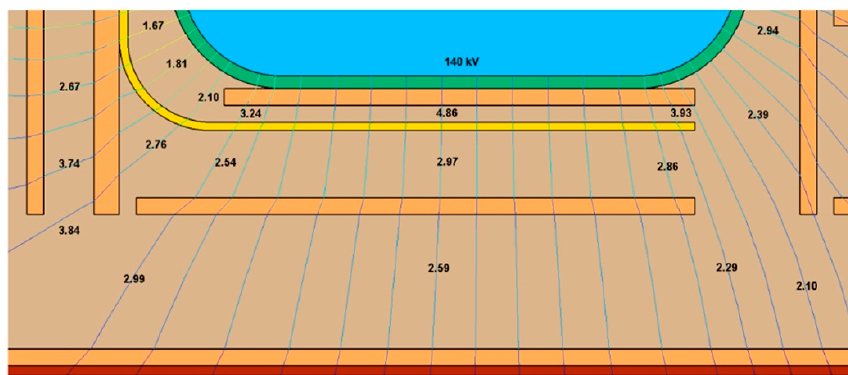
Figure 11. Safety factors for bottom winding .